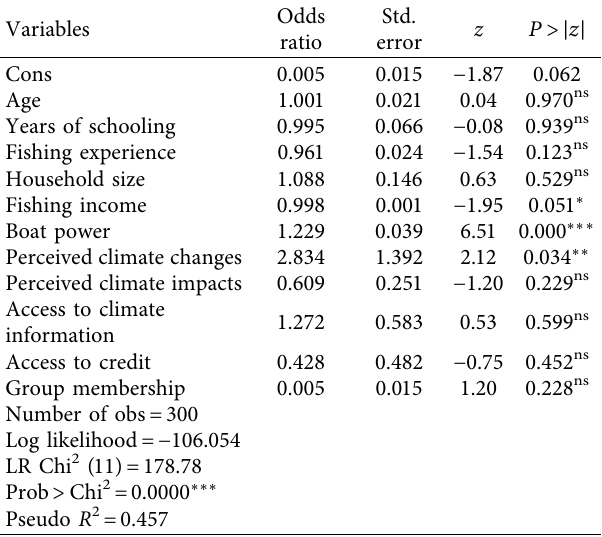
Table 8: Results of binary logistic regression of adaptation